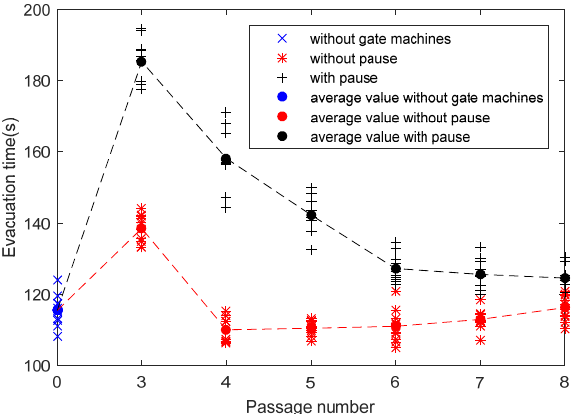
Figure 11. Comparison of evacuation time with and without